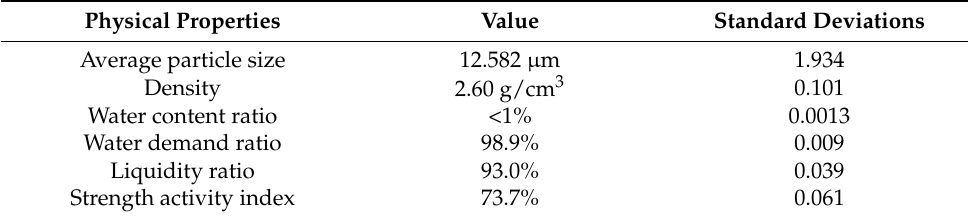
Table 3. Physical properties of CDWC.